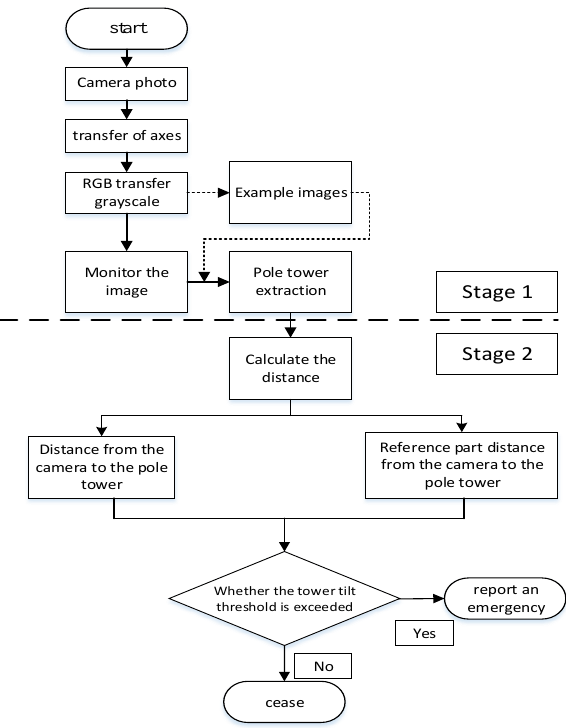
Figure 1. Flow chart of analysis process of tower tilt.